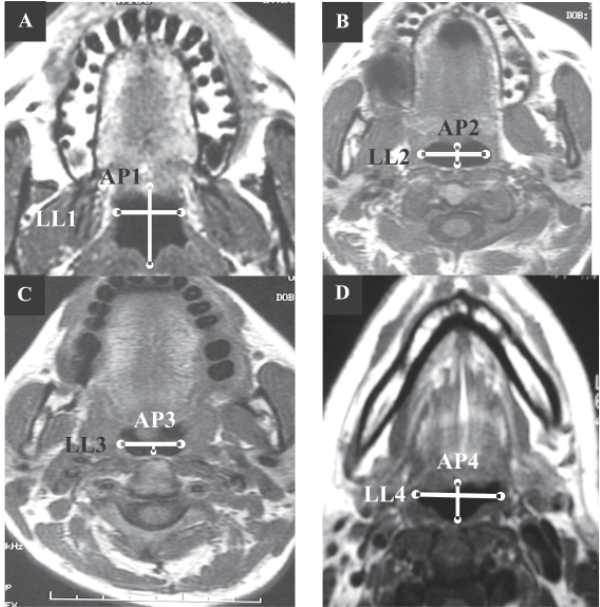
(A) Laterolateral (LL1) and anteroposterior (AP1) air column dimensions at the rhinopharynx. (B) Laterolateral (LL2) and anteroposterior (AP2) air column dimensions at the high retropalatal oropharynx. (C) Laterolateral (LL3) and anteroposterior (AP3) air column dimensions at the low retropalatal oropharynx. (D) Laterolateral (LL4) and anteroposterior (AP4) air column dimensions at the retrolingual oropharynx. Figure 5 - (A, B, C, and D) – Morphology of the pharyngeal air